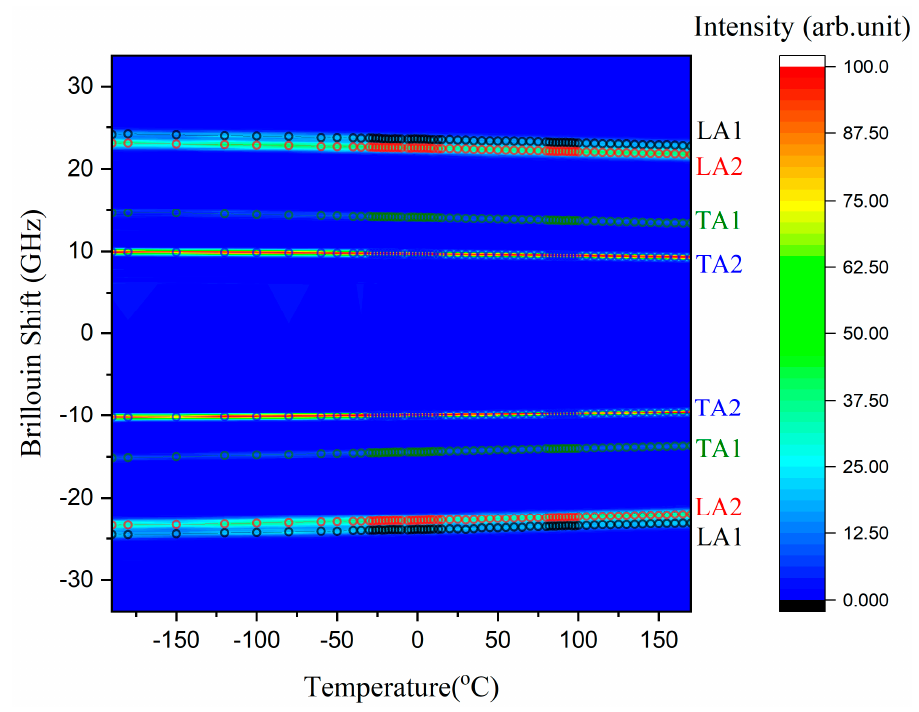
Figure 3. The intensity color plot of the measured Brillouin spectra as a function of the temperature. Mode frequencies are denoted in terms of circle symbols.